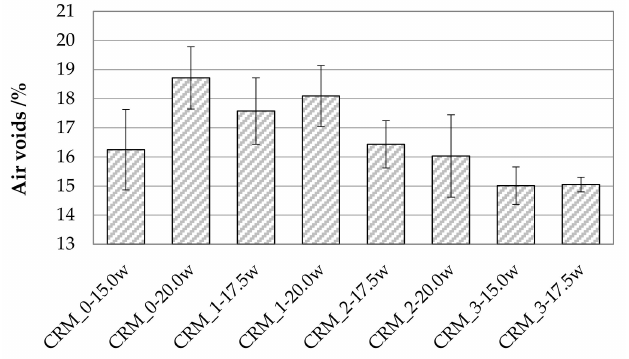
Figure 6. Average air void contents of investigated CRMs.